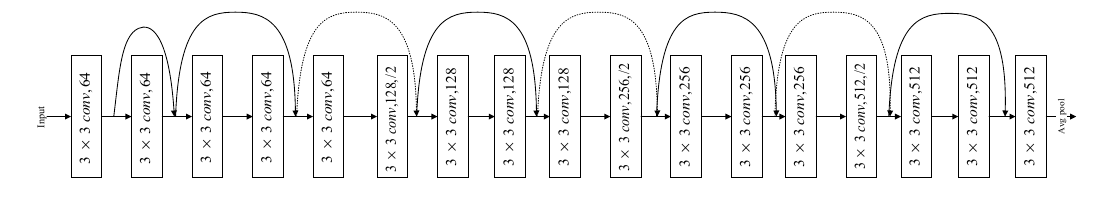
Figure 11. Basic structure of ResNet18.